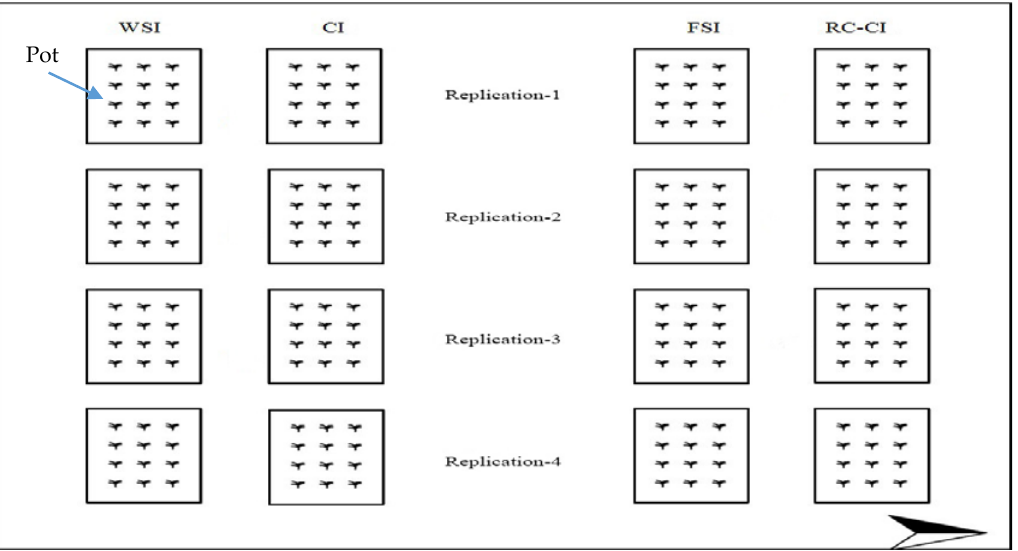
Figure 3. Arrangement diagram of rice pot planting experiment.